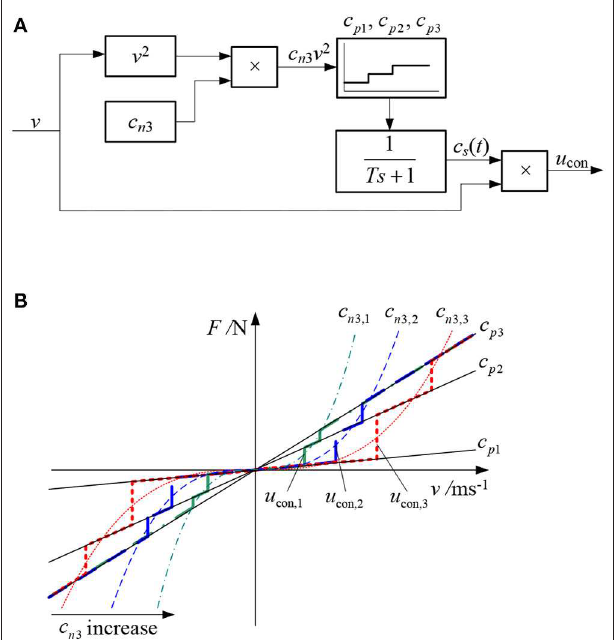
FIGURE 3 | Semi-active implementation of non-linear damping-based isolator. (A) An illustration of the semi-actively implemented non-linear damper. (B) Semi-actively implemented damping forces under different cubic non-linear damping schemes.